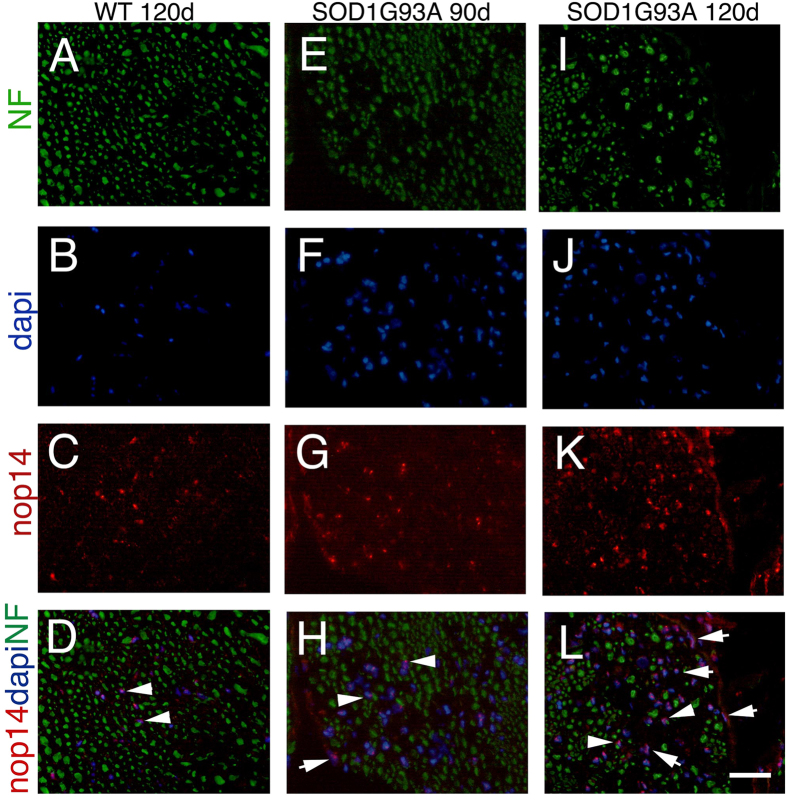
Expression of NOP14 in the sciatic nerve of normal and SOD1G93A mice.Tranverse sections from wild-type (A–D), SOD1G93A mice at 90 days (diseases onset) (E–H) and 120 (end-stage disease) (I–L) double-stained for neurofilament (green), to recognize axons, and NOP14 (red). DAPI staining of nuclei (blue). Nop14 immunoreactivity was present in cell nuclei in wild-type nerves (arrowhead, merge in D); NOP14 shows an increase expression in SOD1G93A nerves in cell nuclei of the Schwann cells (arrowhead, merge in H and L); perineurial cells were also positive for NOP14 (merge in H and L, arrows). Bar: (A–L) 120 μm.